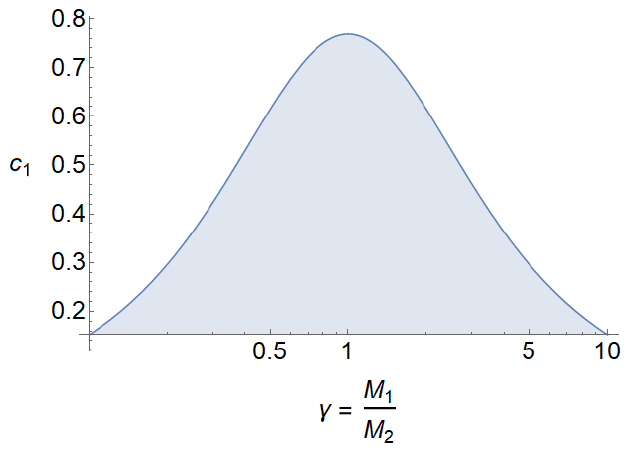
Figure 7 . The allowed values of the cubic coupling, c 1 , obtained from the hf ! hf scattering as a function of (cid:13) for the case where all the other couplings are taken to be Z 2 symmetric (and in particular x = 1). The maximum value for the cubic coupling occurs at (cid:13) = 1 and is again c Z 2 = 0 : 1max